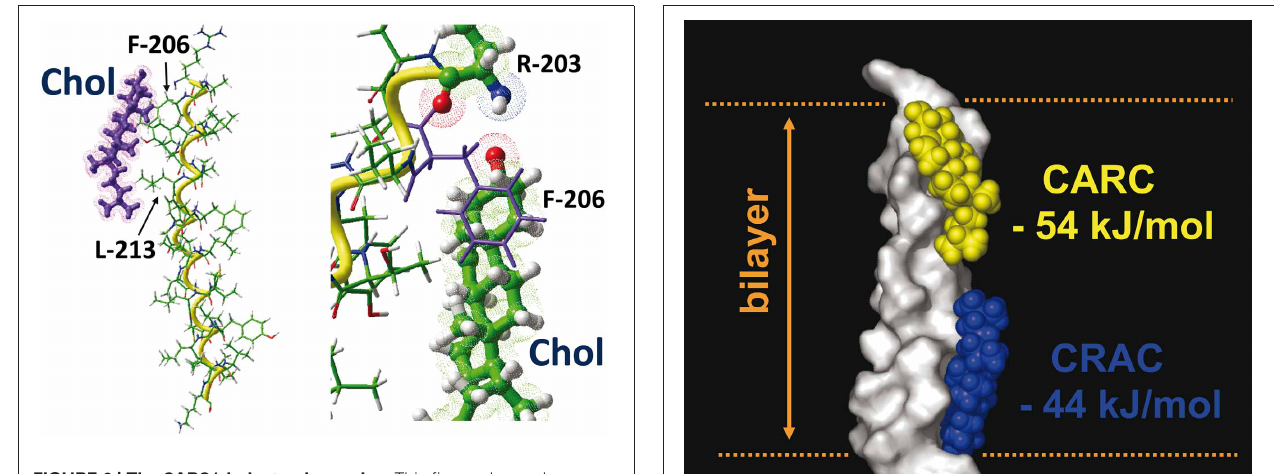
FIGURE 6 | The CARC/cholesterol complex. This figure shows the docking of cholesterol on the CARC domains of the TM5 domain of the human type 3 somatostatin receptor. The CARC domain (fragment 203-RAGFIIYTAAL-213)is located in the extracellular leaflet of the TM5 domain of the receptor. Two distinct views of the complex are shown, one with the whole TM5 domain (left panel), the other with residues R-203 and F-206 enlightened. Note the CH- π stacking interaction of the phenyl ring of F-206 onto the A ring of the sterane backbone of cholesterol. The large aliphatic chain of L-213 interacts with the isooctyl group of cholesterol.